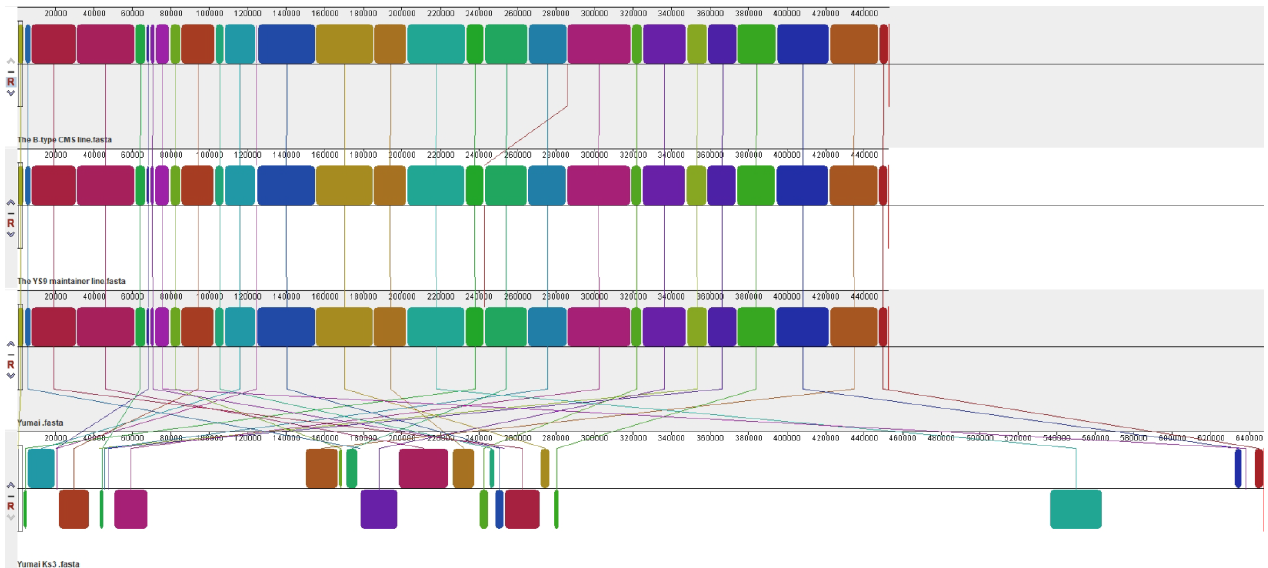
Figure 5. The constructed phylogenetic tree was based on the mitogenomes of seven higher plants ( Triticum aestivum : AP008982; T. aestivum cv . Chinese Yumai Ks3: GU985444; T. aestivum cv . Chinese Yumai: EU534409; T. timopheevii : AP013106; and Aegilops speltoides : AP013107). The numbers represent the evolutionary divergence time of each species.